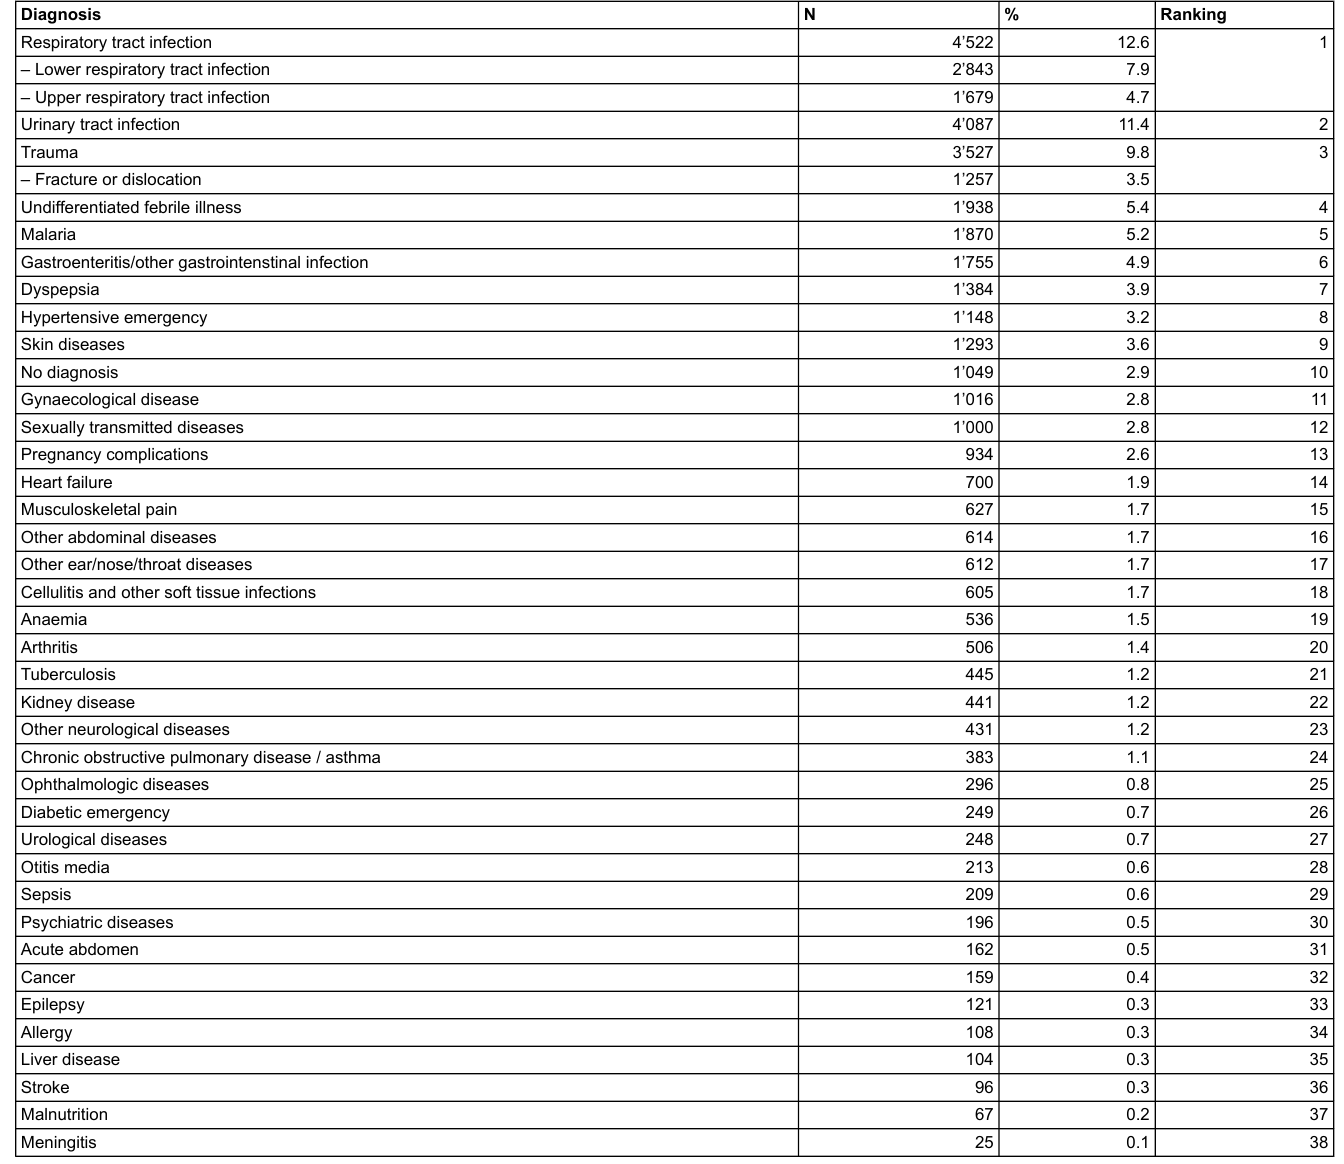
Table 2: Diagnoses of 35’903 patients (simplified diagnosis group